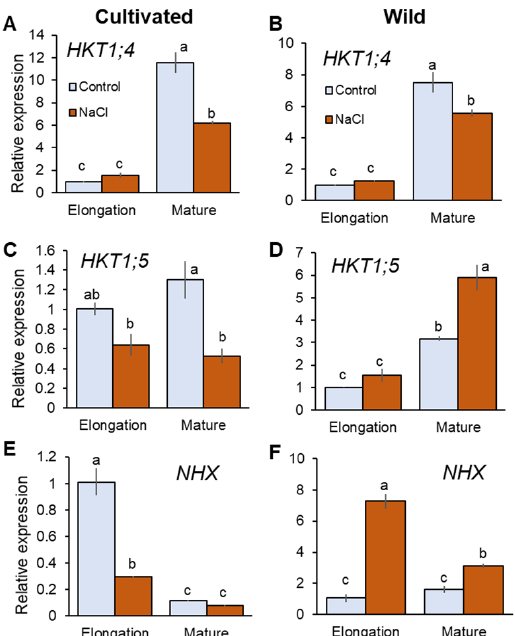
Figure 4. RT-qPCR analysis of the gene expressions of HKT1;4 ( A , B ), HKT1;5 ( C , D ), and NHX1 ( E , F ) in mature and elongation root zones of cultivated and wild rice species under control and salinity (100 mM NaCl, 48 h) conditions. Different letters indicate significant differences ( p < 0.05, one-way ANOVA followed by LSD tests). Mean ± SE ( n =